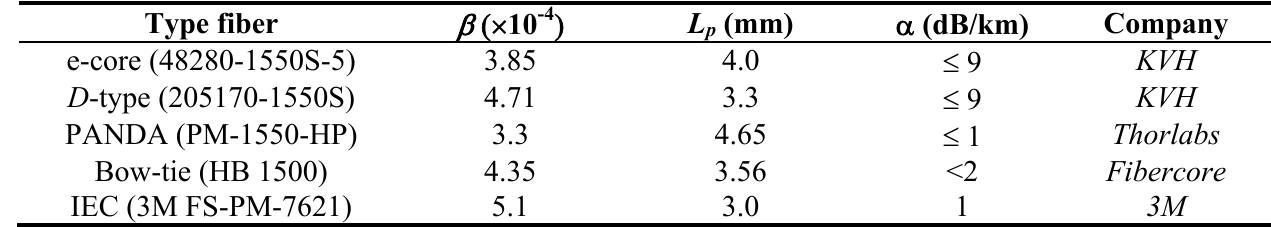
Table 1. Typical parameters of standard commercial Hi-Bi